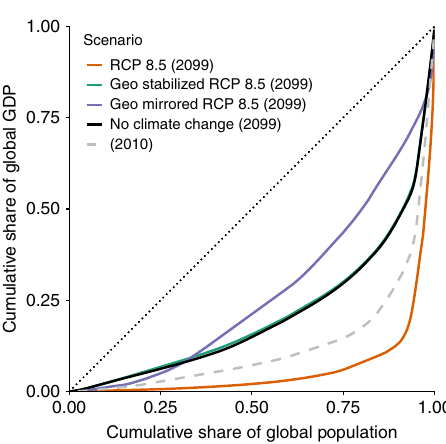
Fig. 3 Lorenz curves of global income distribution in 2100. Curves are estimated using the model in column (1) of Supplementary Table 1 and Supplementary Table 1 for Shared Socioeconomic Pathway (SSP) 3. Cumulative global income vs. cumulative global population, with global warming (RCP8.5, orange), no warming, geoengineering stabilized global temperature (geo-stabilized, green) and global cooling (geo-mirrored, purple). Lorenz curve for present day income distribution is indicated by dashed line. The distribution that would be observed with perfect equality is represented by the dotted line. See Supplementary Materials for other SSPs, climate-economy model speci fi cations (Supplementary Fig. 7).